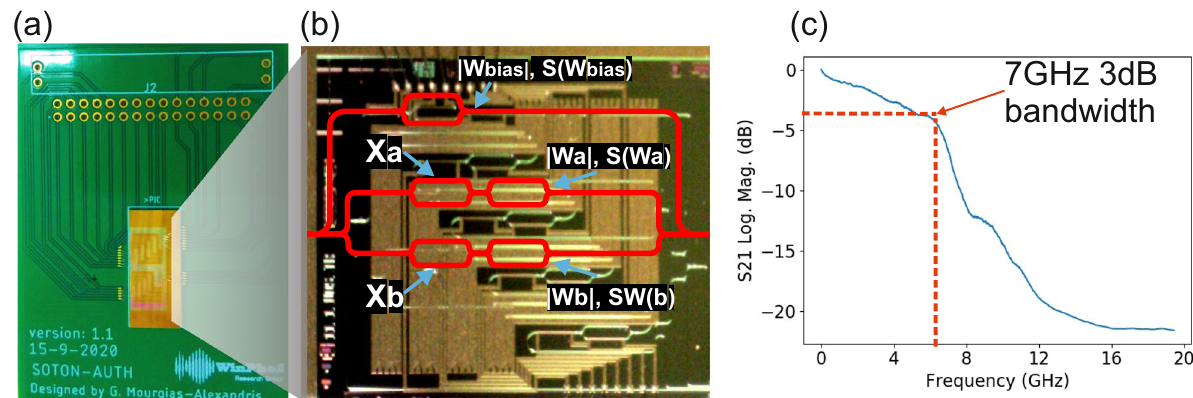
Fig.2|Siliconphotonicneuron.a PhotoofthepackagedSi-Phocoherentneuron, b Microscopetop-view photo ofthe SiPho chip, withtheutilized part of the circuit